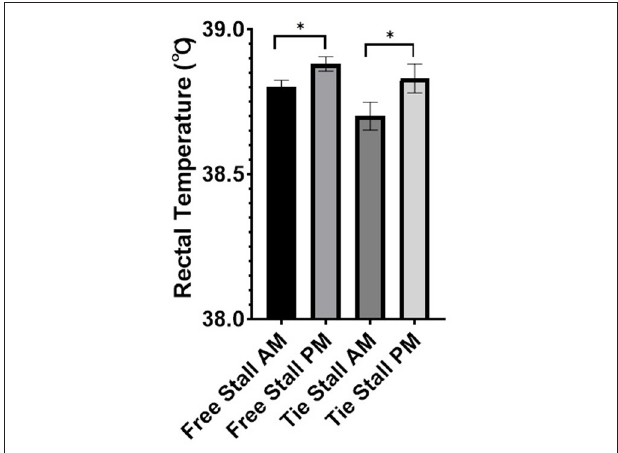
FIGURE 6 | Average rectal temperature in degrees Celsius for free-stall vs. tie-stall. Data are presented as least squared means of untransformed data, with error bars representing standard error for each mean. Trends [free-stall ( p = 0.09), tie-stall ( p = 0.10)] are represented by single stars above the error